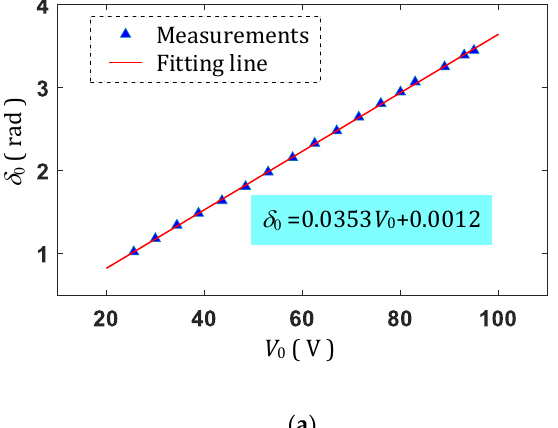
 , ( a )  vs. V , at a wavelength of 0.532  m; ( b ) 0 0 0  vs.  curve. 0